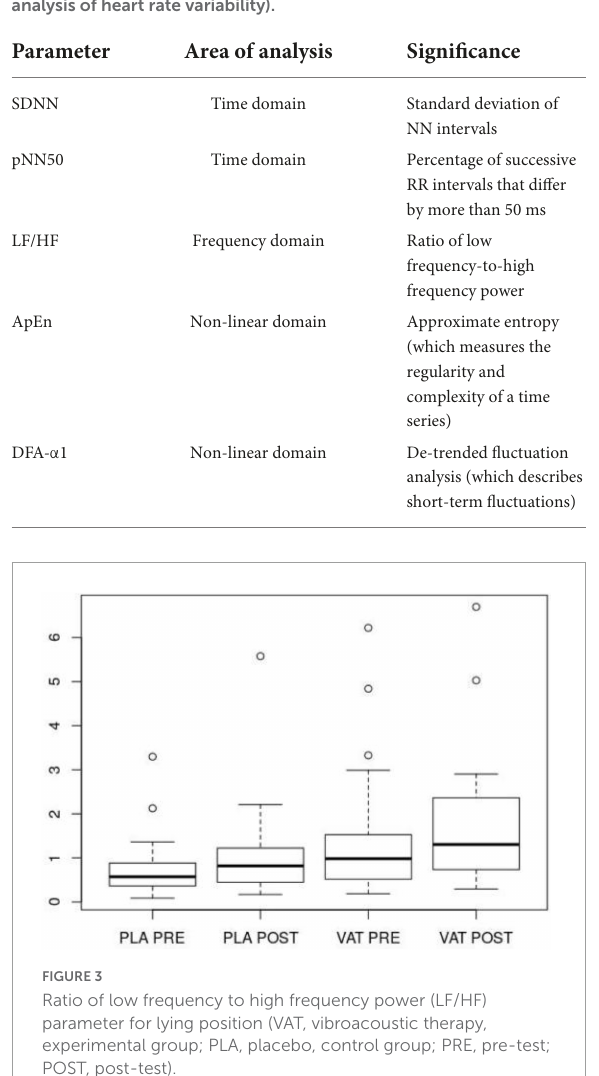
TABLE 3 Parameters chosen for statistical analysis of HRV SA (spectral analysis of heart rate variability).